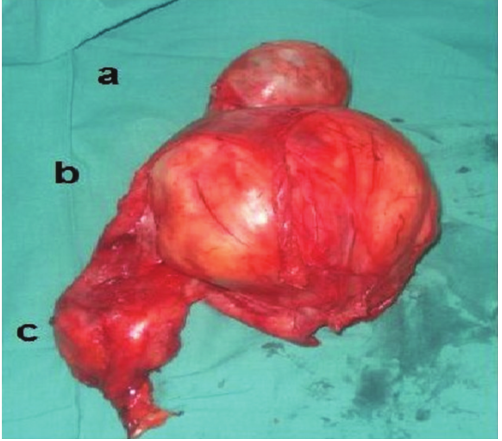
Figure 2: Macroscopic findings: (a) normal testis, para testicular tumors measuring 15cm (b) and 4cm